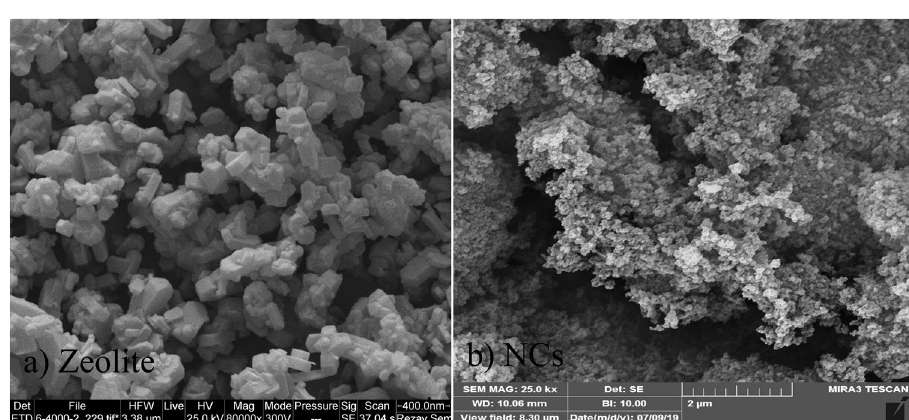
Figure 5. SEM images of a: zeolite and b: zeolite-zirconia-copper